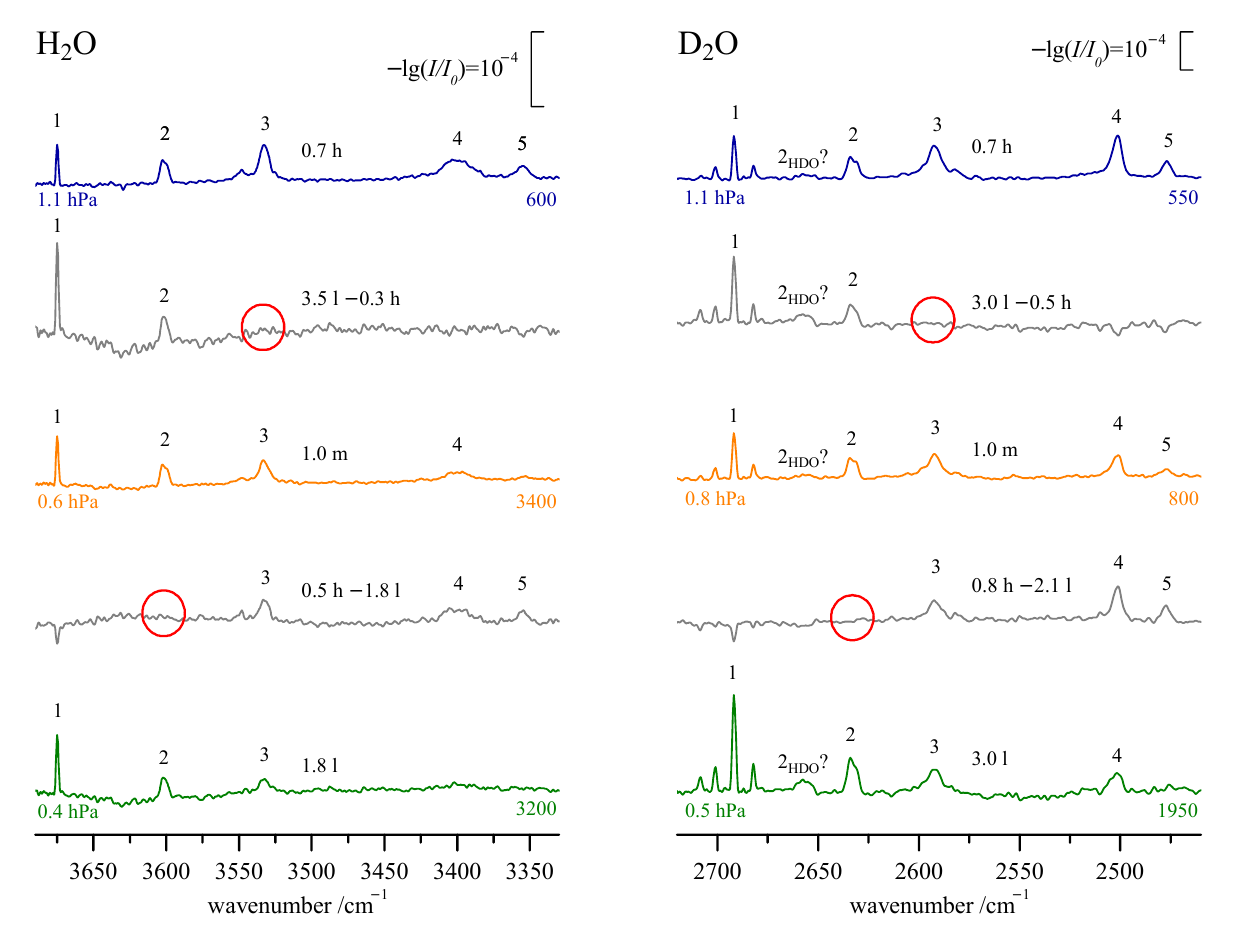
Figure 11. Separation of spectral contributions from H 2 O (left panel) and D 2 O (right panel) dimers (2) and trimers (3) in linear absorption supersonic jet spectra recorded in 750hPa neon expansions by comparing a high water partial pressure (h, top trace, 1.1hPa) with a low partial pressure (l, bottom trace, 0.4 and 0.5 hPa) spectrum and taking their weighted differences such that the trimer (next-to-top) or dimer (next-to-bottom) contributions quantitatively vanish (circled areas). The spectra are intensity scaled to approximately match the dimer (upper part) or trimer (lower part) intensity of a medium partial pressure (m, central trace, 0.6 or 0.8 hPa) spectrum. They also contain monomer transitions (1) and tetramer/pentamer contributions (4/5), the latter known to narrow down upon deuteration [75–78]. The number of co-averaged gas-pulses is given below the left end of each spectrum. Such spectra would be prohibitively expensive without recycling the neon gas (total gas flow of about 40000 standard